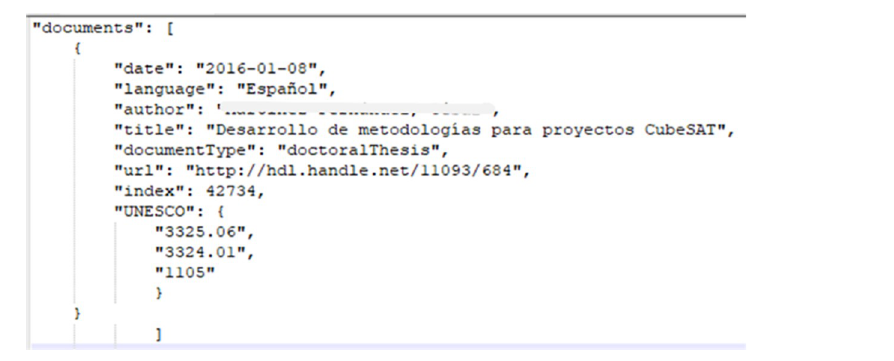
Fig 2. Stored document metadata.